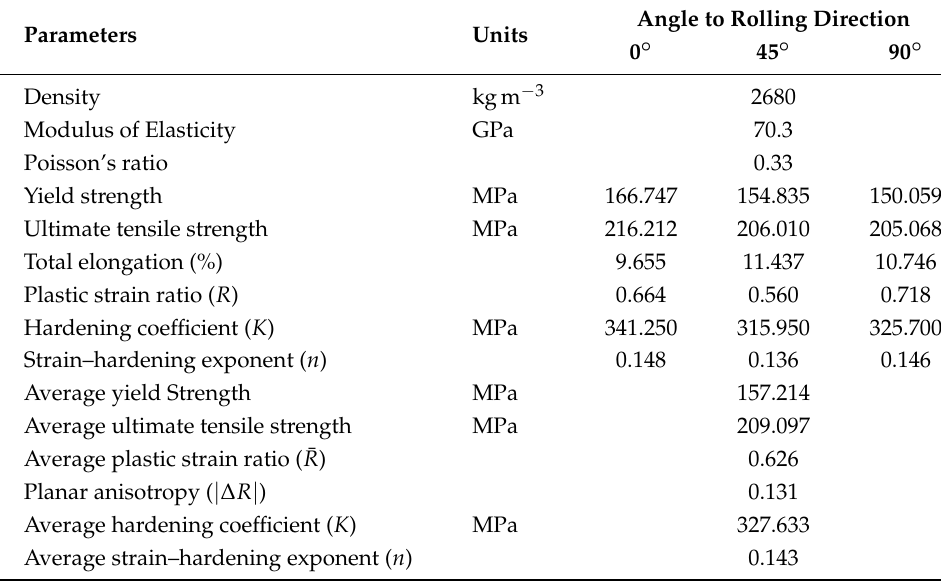
Table 1. Mechanical properties of the AA5052–H32 material model.